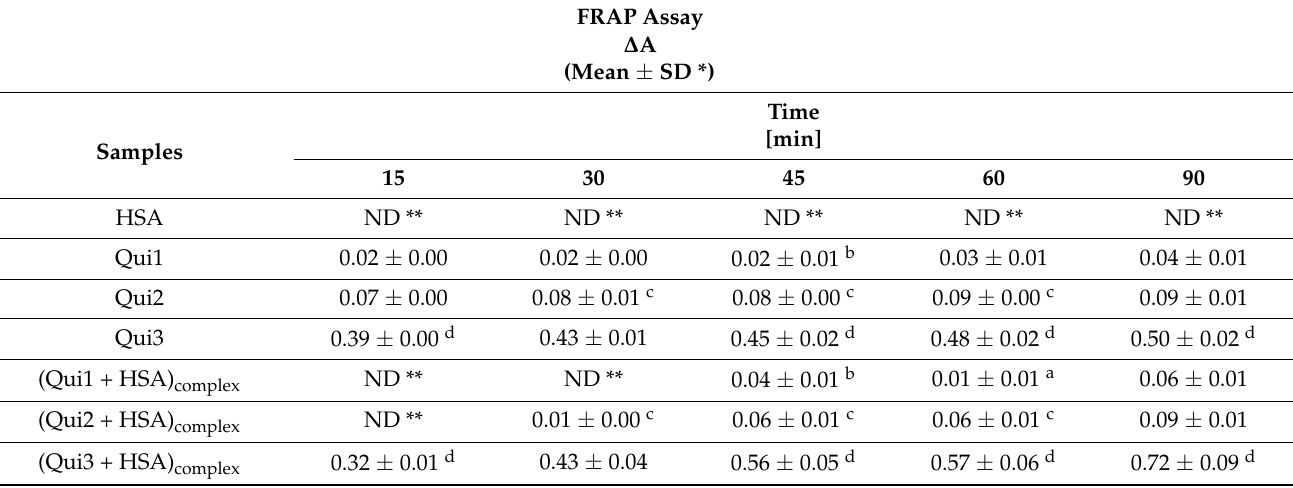
Table 10. The value of ∆ A of Qui1–Qui3 ([Qui1] = [Qui2] = [Qui3] = 5 × 10 − 4 M), HSA ([HSA] = 2.5 × 10 − 4 M), and (Qui1 + HSA) complex , (Qui2 + HSA) complex , (Qui3 + HSA) complex